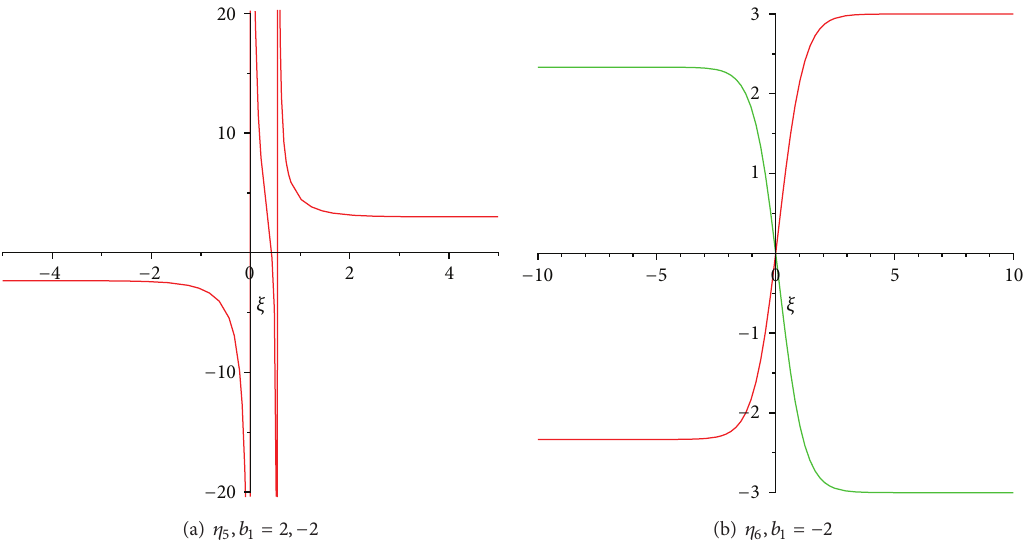
Figure 4: 2D figures of solution 𝜂 5 (𝜉) in (38) and 𝜂 6 (𝜉) in (39) with 𝑎 = −1 , 𝐵 = −4 , Ω = 4 , 𝑀 = 3 , 𝐸 = 1 , Ψ = 1 , and 𝐴 = 1 in the intervals 𝜉 ∈ [−10,10]